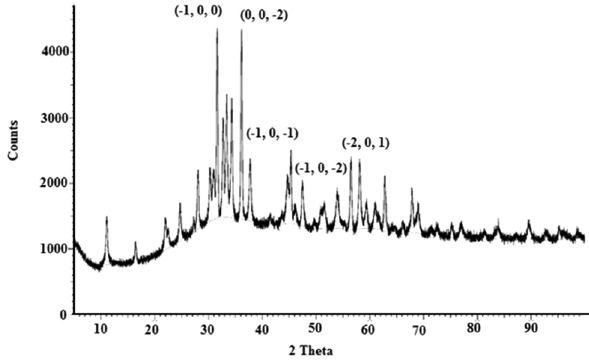
Figure 6: XRD patterns of the synthesized calcined